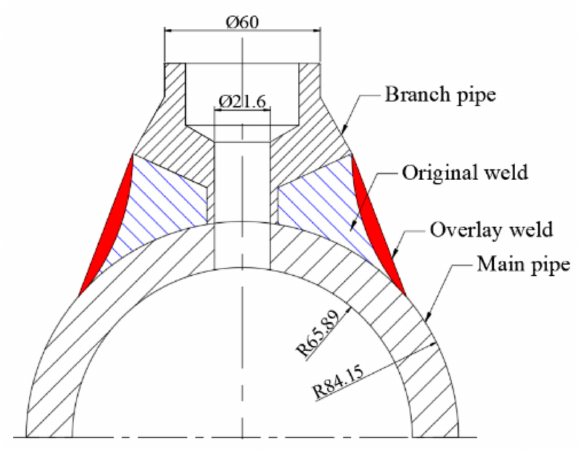
Figure 2. Dimensions of the T-pipe